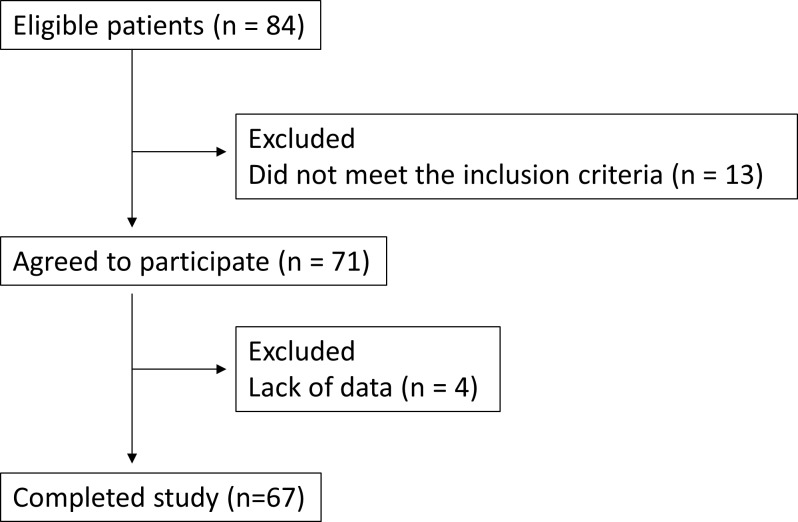
Patient flow chart.